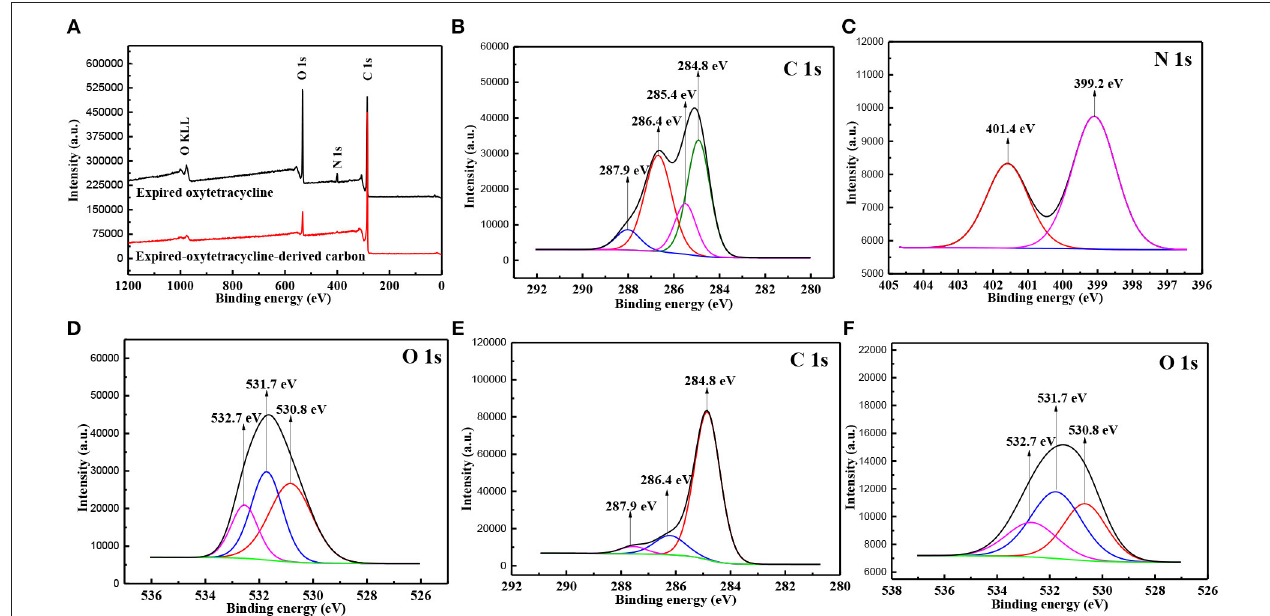
FIGURE 4 | The wide scan XPS spectra (A) of expired oxytetracycline and its derived carbon powders, spectra of (B) C 1s, (C) N 1s and (D) O 1s in expired oxytetracycline, and spectra of (E) C 1s, (F) O 1s in expired-oxytetracycline-derived carbon.